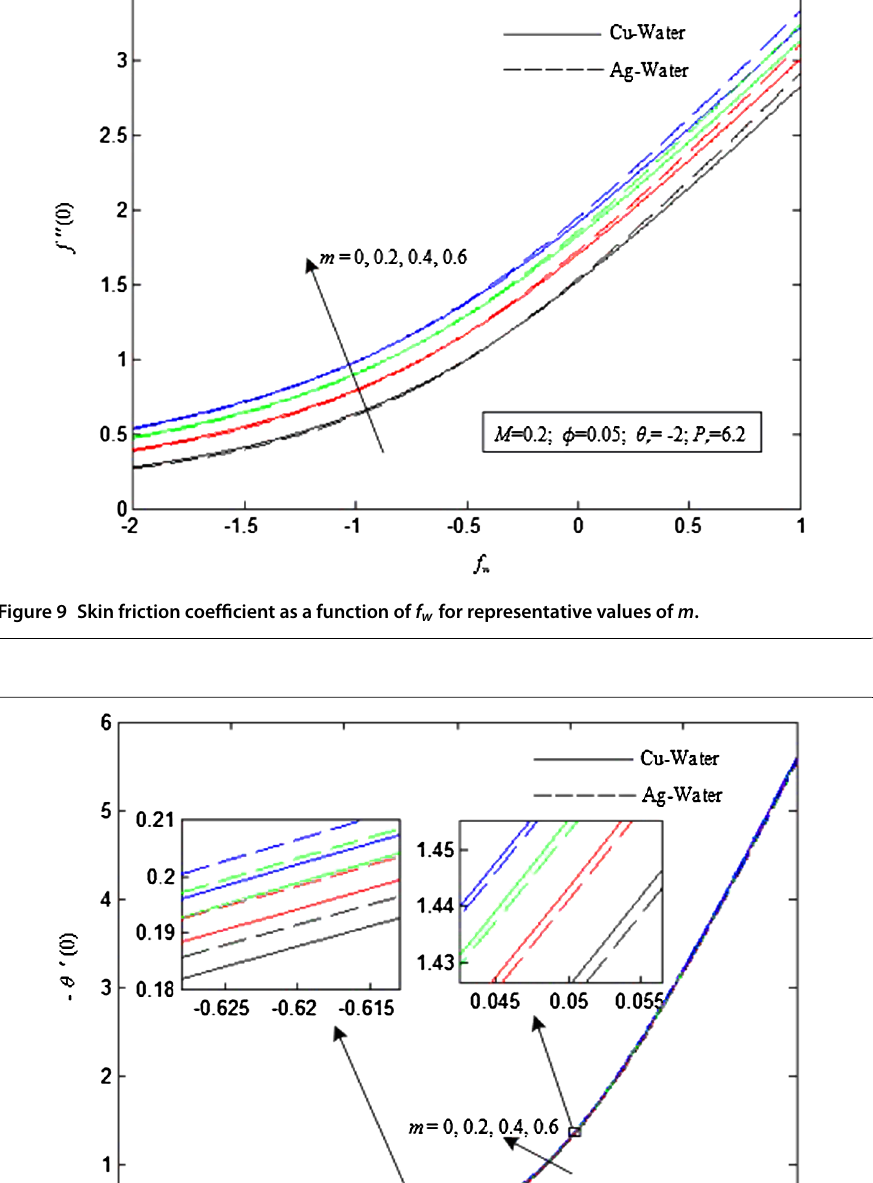
a larger skin friction coefficient but a slightly lower rate of heat transfer coefficient than that of Ag-Water nanofluid for deep injection ( f w < –.), while the opposite is true for suction ( f w > ). Note that the effect of m on the rate of heat transfer coefficient is much less than that on the skin friction coefficient and almost vanishes when f w =